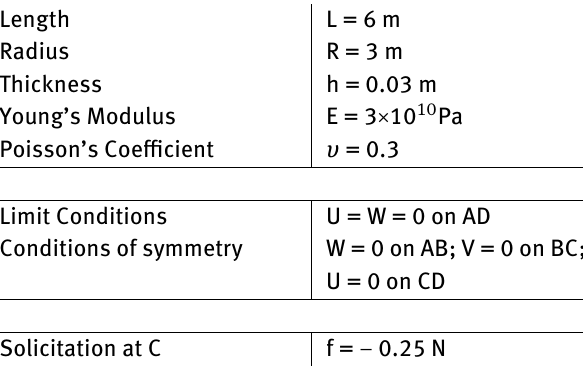
Table 2: Geometry and mechanical data of the pinched